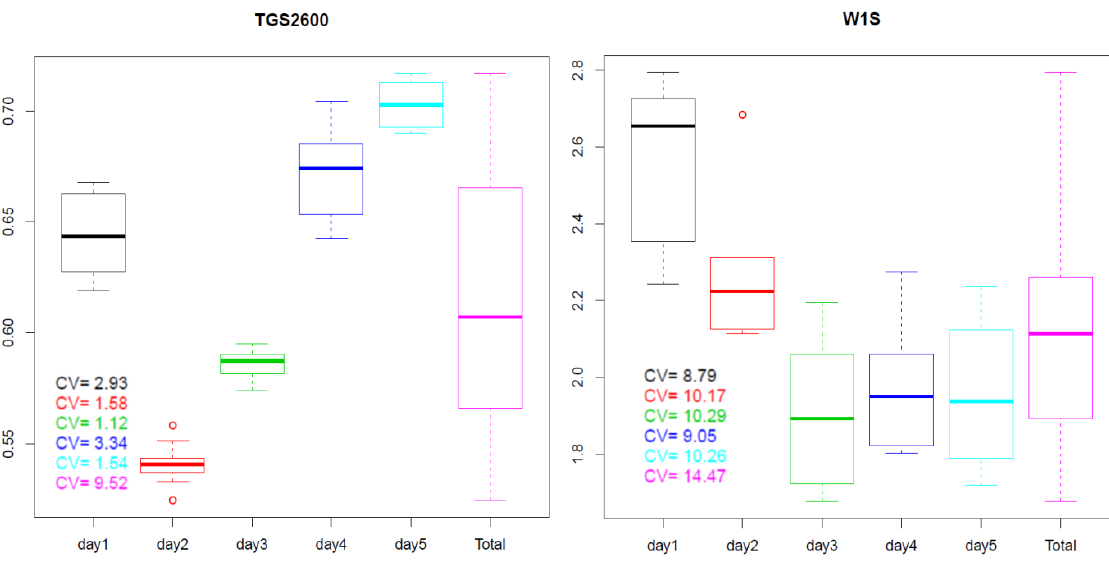
Figure 6. Boxplots of the distributions of the AVR feature for the R/R